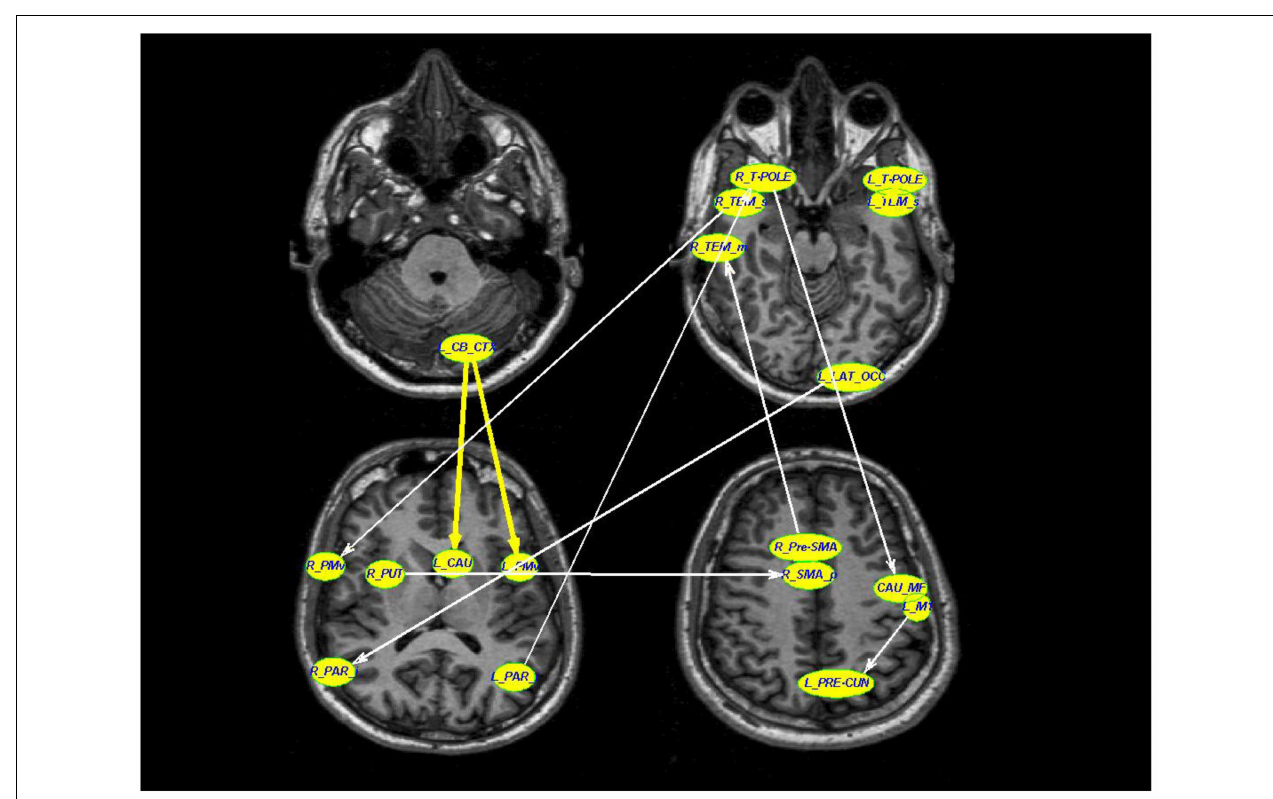
superior temporal (R_TEM_s) to right ventral premotor area (R_PMv) ( p = 0.03), 2. Right putamen (R_PUT) to right supplementary motor